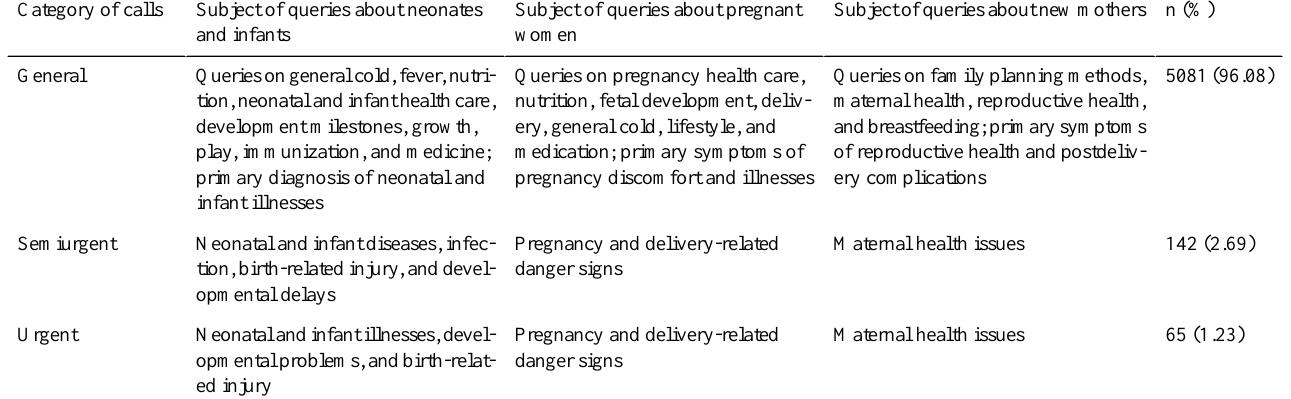
Table 2. Category of calls